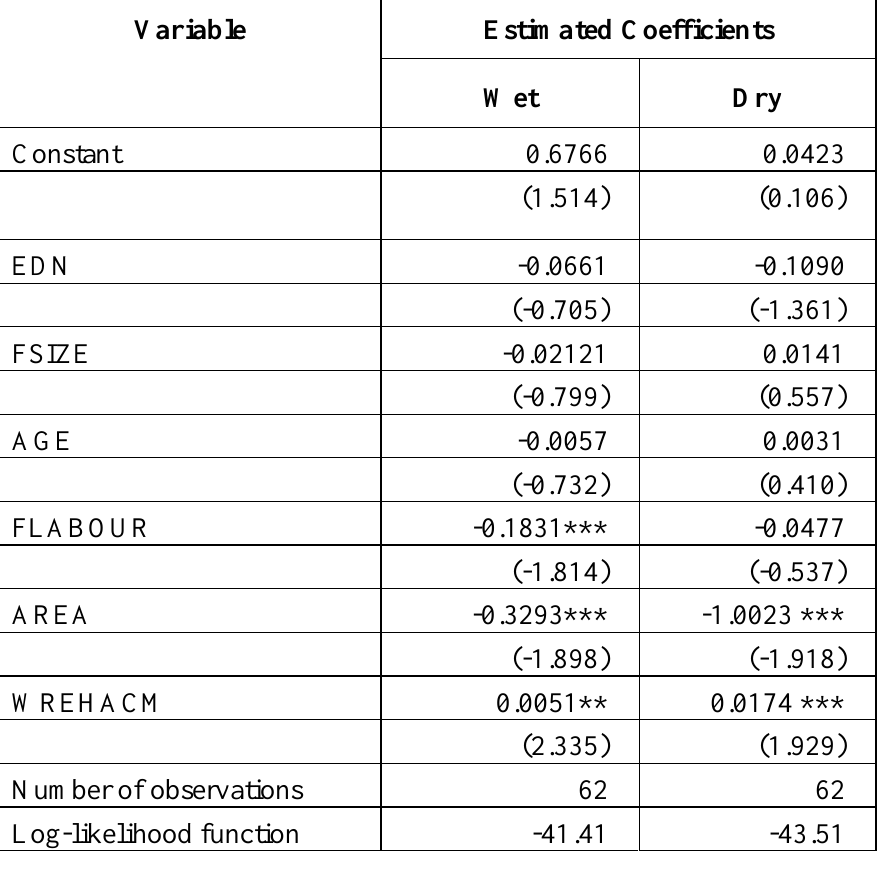
Table 1. Logit estimation of factors influencing farmers’ WTP for irrigation